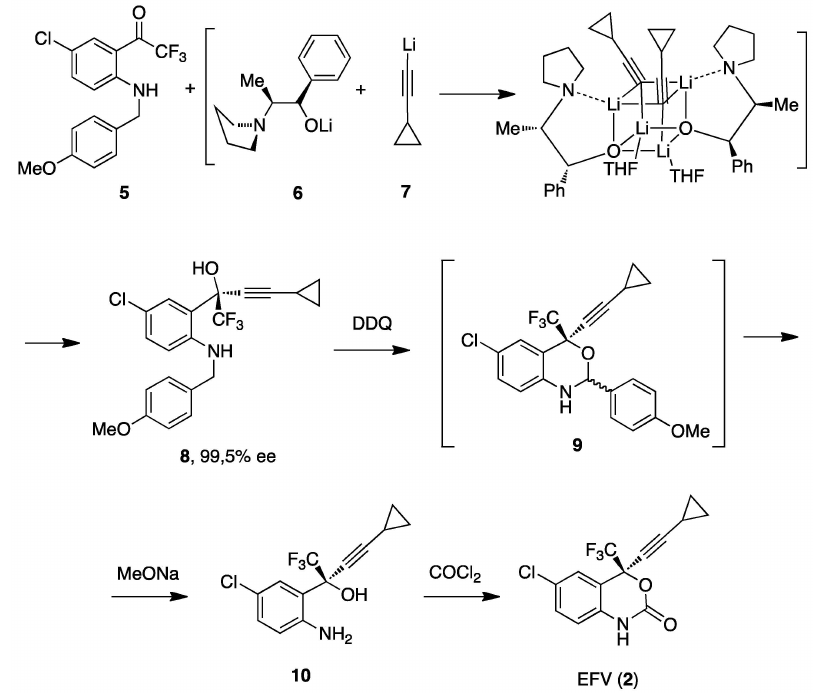
Scheme 3. Thompson enatioselective synthesis of efavirenz.